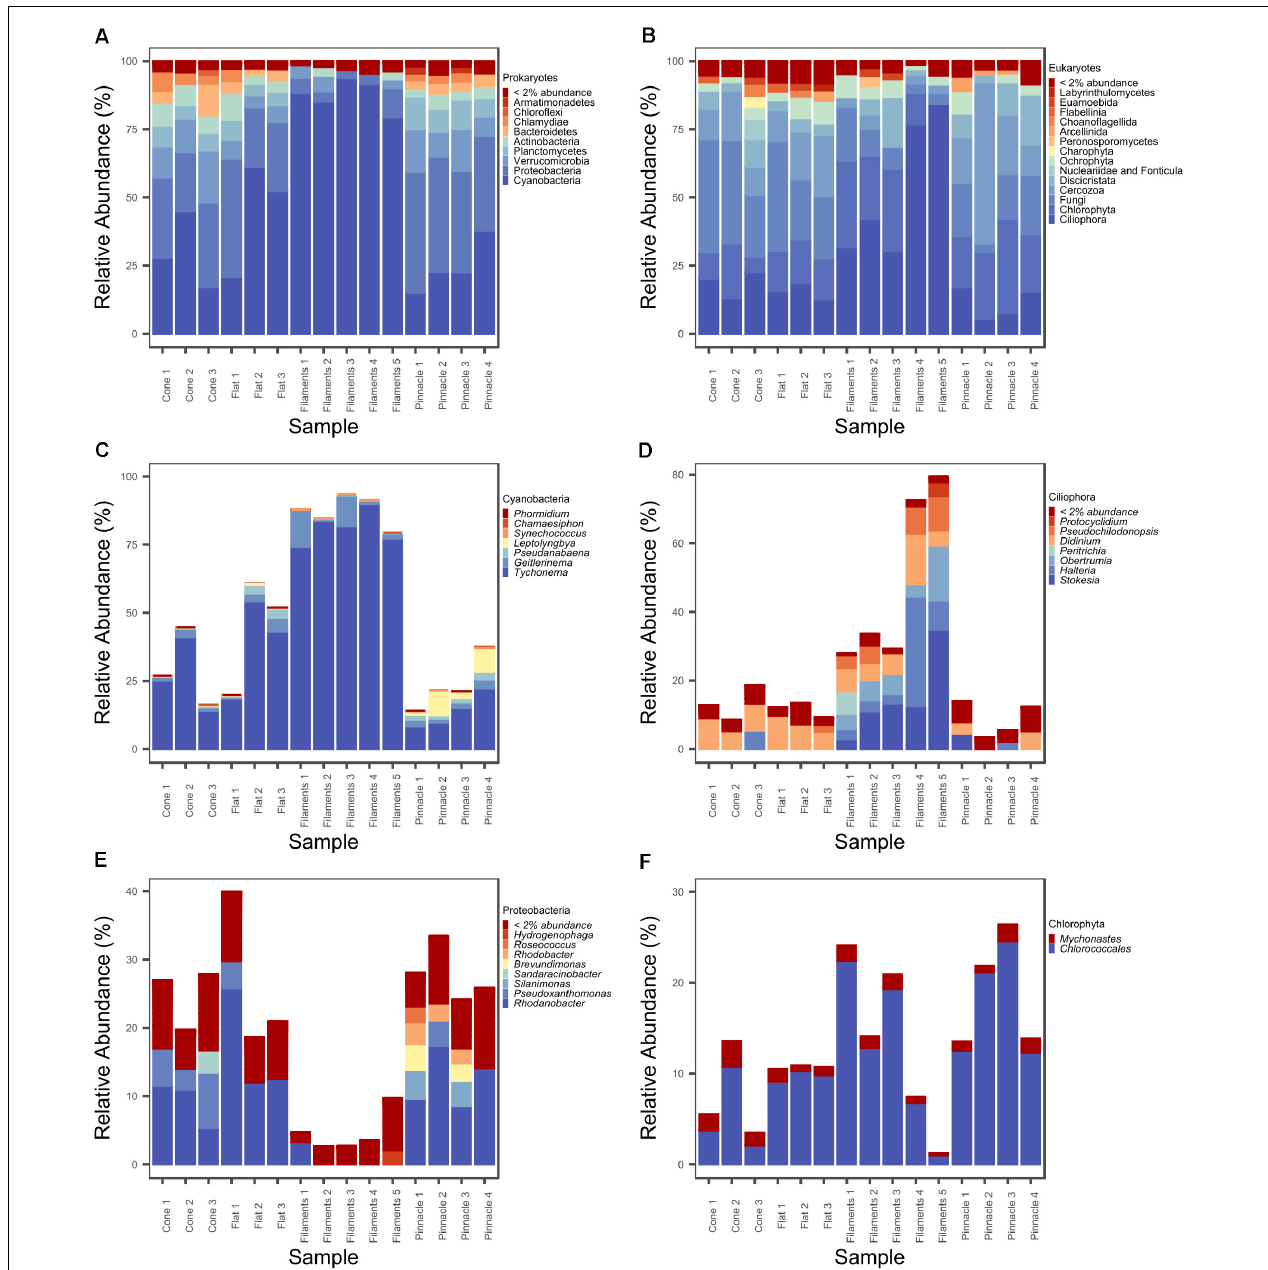
FIGURE 4 | Relative abundance (%) plot of (A) prokaryotic phyla, (B) eukaryotic major groupings, (C) cyanobacterial genera, (D) ciliophoran genera, (E) proteobacterial genera, and (F) chlorophyte genera.